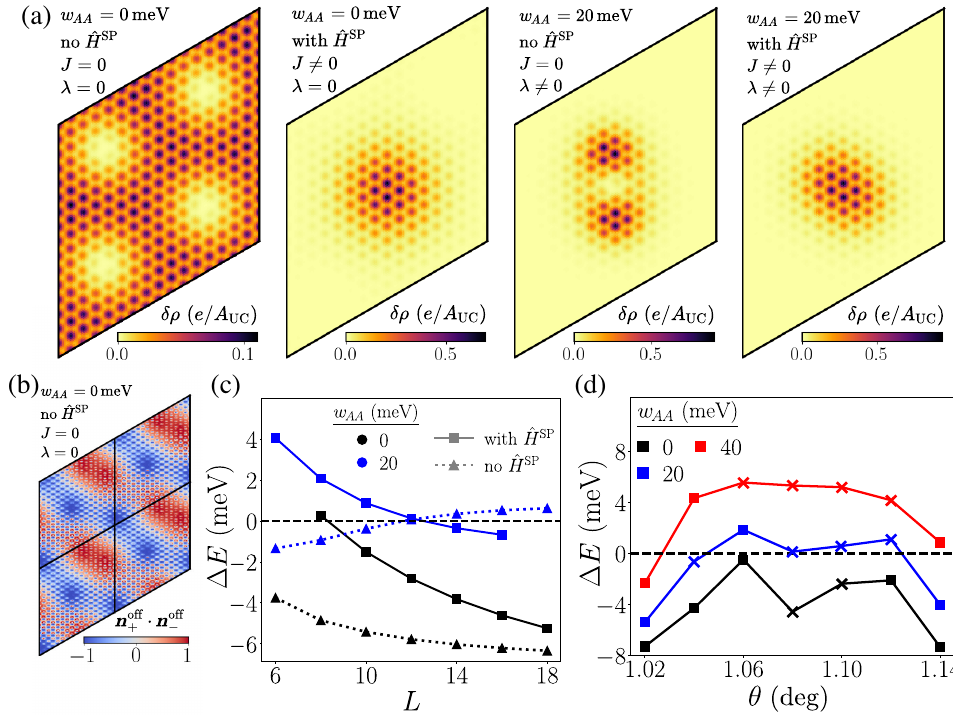
FIG. 4. Properties of 2 e skyrmions (spinless ν ¼ 0 ). (a) Charge density δρ ð r Þ of 2 e skyrmions in the entire simulation cell relative to the ν ¼ 0 ground state. Panels show different combinations of turning on or off dispersion and achirality, which determine J and λ . Calculations performed on 16 × 16 systems at θ ¼ 1 . 05 °. Textures manually translated to the center for clarity. (b) Local alignment of Chern pseudospins corresponding to the leftmost panel of (a). The system cell is duplicated three times for presentation. (c) Relative − E 2 e skyrmions (compared to adding two particle excitations) as a function of the system size. Both E energy Δ E ¼ E 2 e 2 e of skyr and E 2 e are computed self-consistently; Δ E < 0 indicates that the 2 e skyrmion is favored. (d) Δ E for different θ and w AA . Dispersion is always included. Note that most of the solutions (indicated with crosses rather than squares) for 1 . 05 ° < θ < 1 . 13 ° are not paired skyrmions. System size is 11 × 11 . All calculations use the average scheme (see Appendix A in Ref.